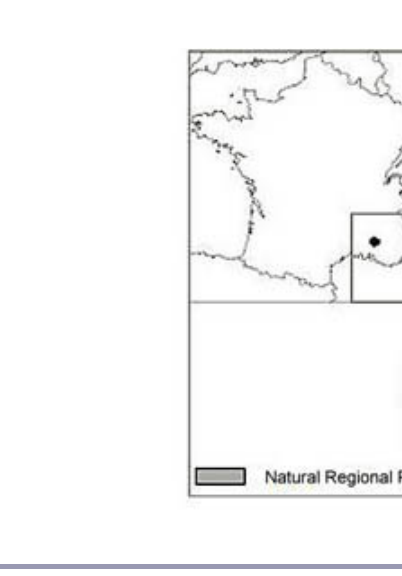
Fig. 1. Map of study area indicating the village of Lauris within the Natural Regional Park of the Luberon in the French Mediterranean